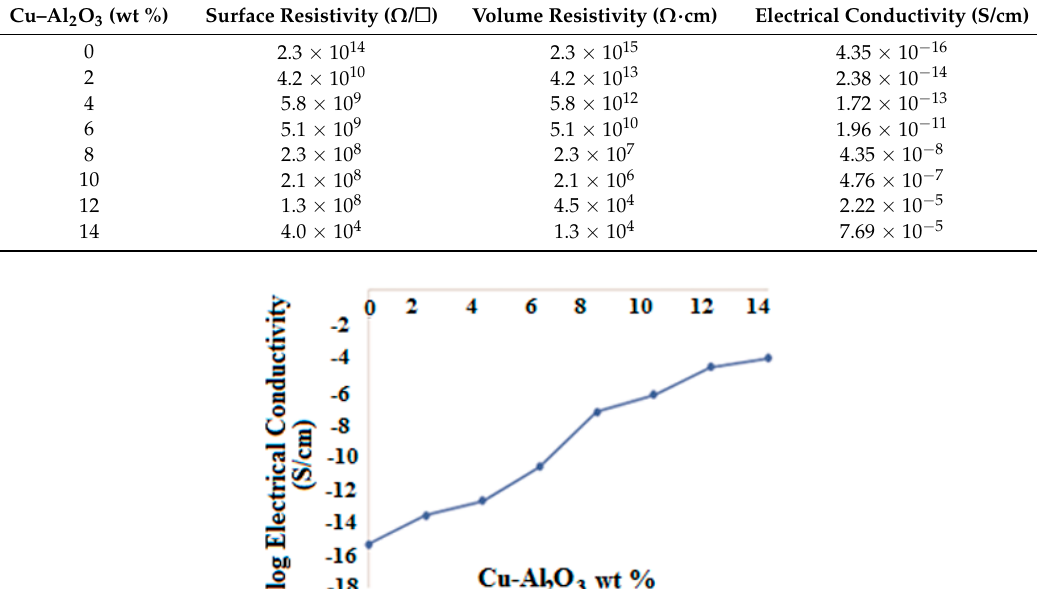
Figure 6. Electrical conductivity of Cu–Al 2 O 3 /PS- b -(PE- r -B)- b -PS- g -MA composites.